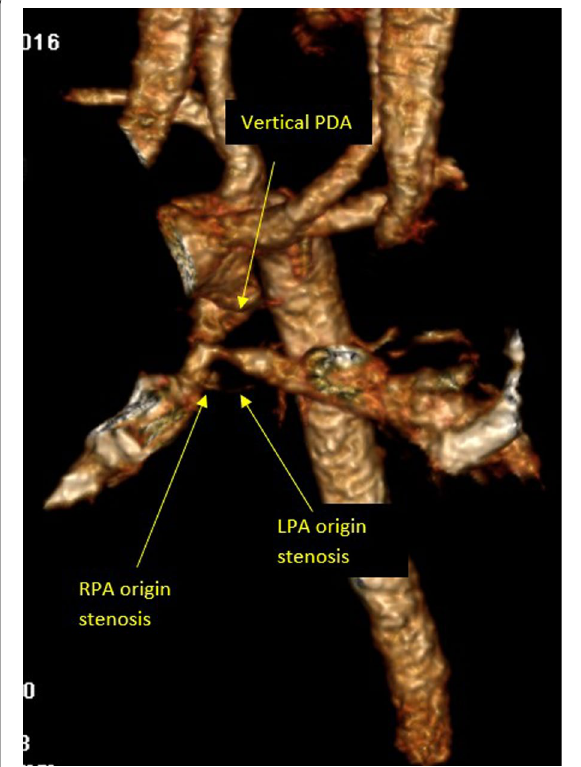
Fig. 5 3D volume rendering image showing vertical PDA supplying hypoplastic pulmonary tree with bilateral pulmonary artery branches origin